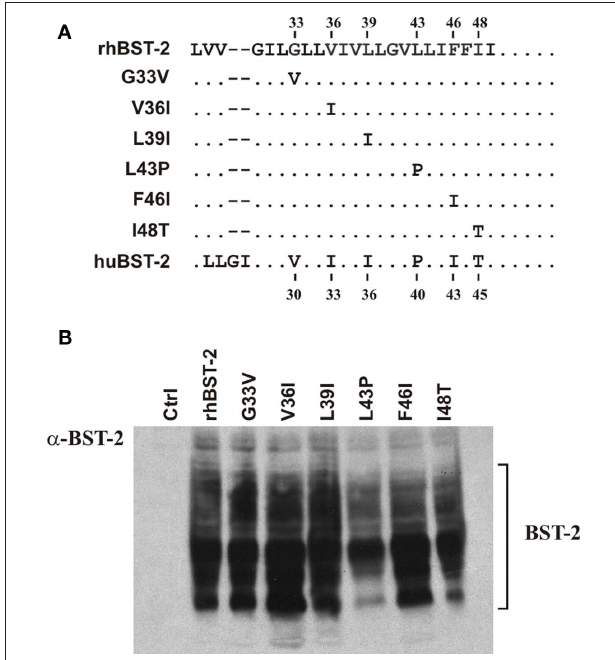
FIgure 5 | Construction of BST-2 point mutants. (A) Sequence alignment of BST-2 TM domain region encompassed by chimera 4. Chimera 4, which is Vpu-sensitive, contains six amino acid differences with respect to rhesus BST-2. Each of the six positions was changed individually to the corresponding human sequence by PCR-based site-directed mutagenesis. Dots represent sequence identities. Amino acid positions at the top refer to rhesus BST-2. Numbers listed at the bottom refer to the corresponding human BST-2 amino acid positions. (B) Expression of BST-2 point mutants was verified by immunoblotting as described for Figure 3C